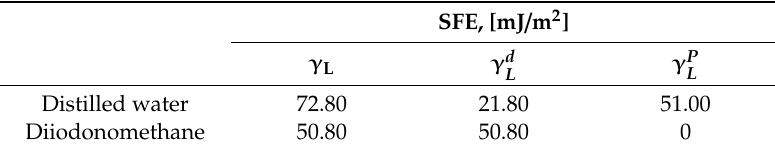
Table 5. The values of surface free energy (SFE) and their polar and apolar components for measuring liquids used in the Owens–Wendt method